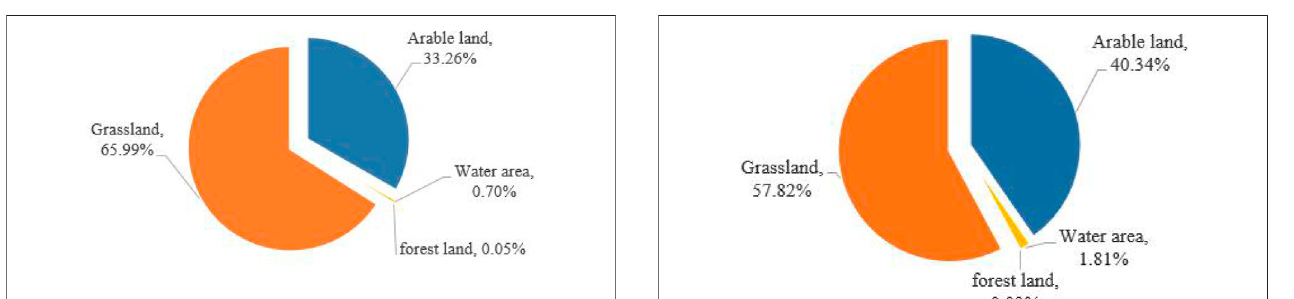
FIGURE 1 | Ecological footprint of Sichuan agricultural system in 2000.